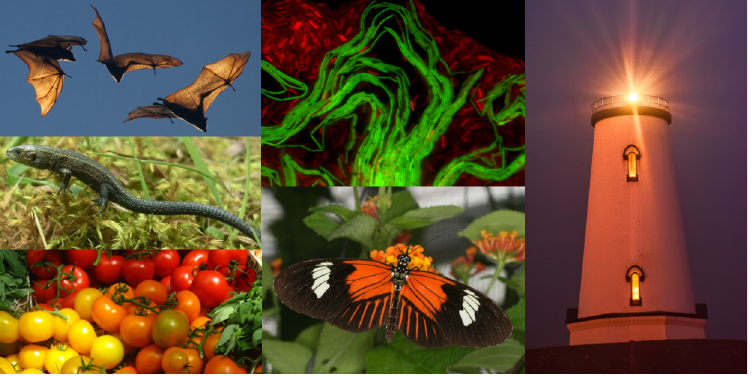
Fig 1. “ Slices of PLOS ” Become “ Open Highlights. ” The successful format of our PLOS Biologue series of “ Slices of PLOS ” (left) will now become the new journal article type Open Highlights (right). Image credits (clockwise from top left) : Flickr user pldms , Jordi van Gestel , Flickr user puliarfanita , Chris Jiggins , Flickr user adactio , Elvire Bestion .